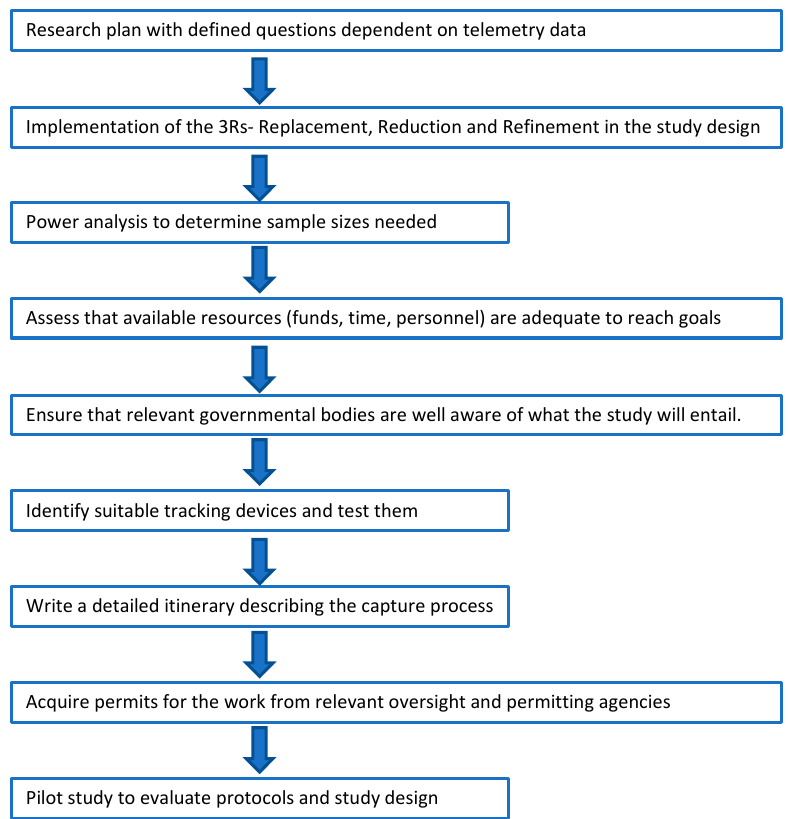
Figure 1. Flowchart summarizing the main steps needed to launch a telemetry